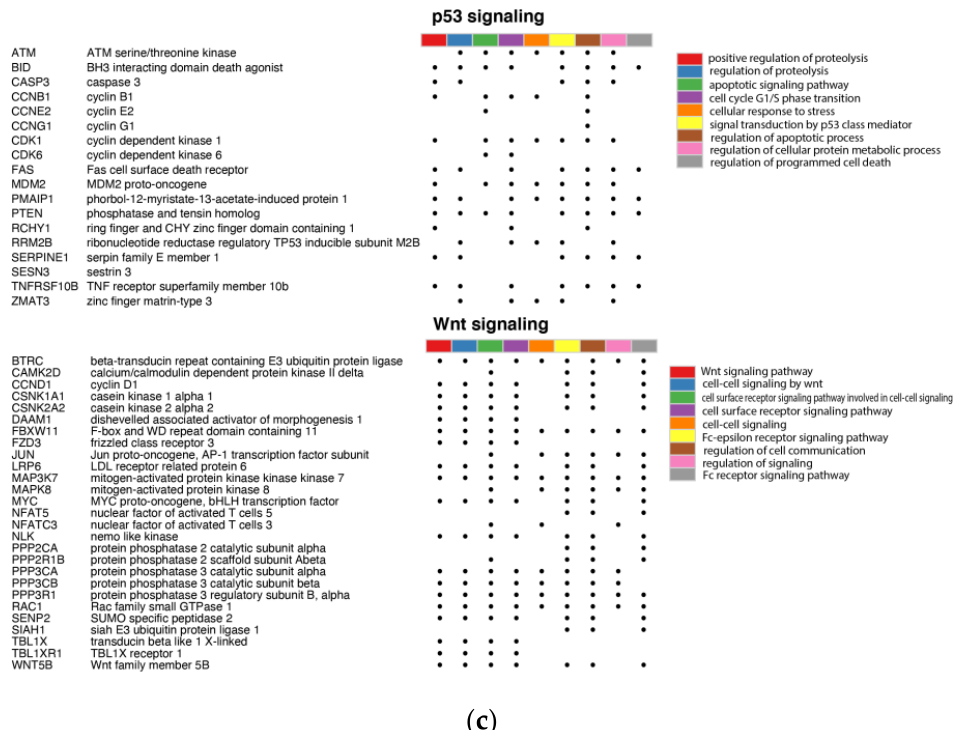
Figure 2. miR-30c-5p target genes are abundant in p53 and Wnt signaling pathways in OSCC. ( a ) Bubble plot containing specific ontological groups of miR-30c-5p validated targets. The graphs show only the GO groups above the established cut-off criteria ( p with correction <0.05, minimal number of genes per group >10). The size of each bubble reflects the number of differentially expressed genes assigned to the GO terms. The transparency of the bubbles displays the p -values (more violet is closer to the border of p = 0.05). ( b ) Graphical view of a network built by the validated miR-30c-5p targets. Targets that belong to p53 and Wnt signaling pathways are highlighted. p53-related genes are marked in yellow, and Wnt are marked in green. ( c ) Detailed overview of target genes involved in regulation of p53 and Wnt signaling pathways. Symbols and gene names are presented with the nine ontological groups with the lowest p -value from the GO BP (gene ontology biological process) database. Individual GO BP categories are marked with an appropriate color. A dot indicates the assignment of a given gene to a specific category.